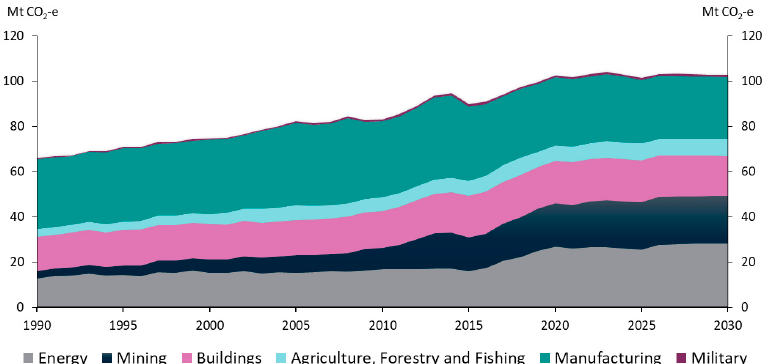
Figure 2. Australian stationary energy emissions, 1990 to 2030, Mt CO 2 -e (Source: Department of Industry, Science, Energy and Resources) .